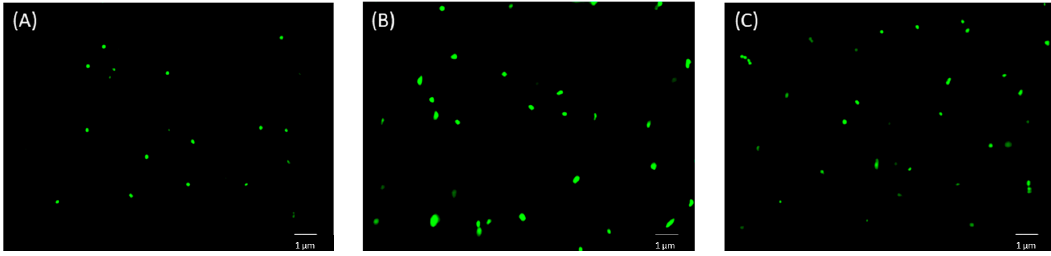
Figure 4. Effect of betulinic acid in the cell volume of ciprofloxacin treated S. aureus measured by fluorescence microscopy. S. aureus ATCC 6538 was incubated with ciprofloxacin (0.019 µg/mL) alone, or in combination with betulinic acid (200 µg/mL). After 3 h, the cells were labeled with acridine orange and analyzed using fluorescence microscopy. ( A ) Non-treated cells; ( B ) S. aureus treated with ciprofloxacin (0.019 µg/mL); ( C ) S. aureus treated with ciprofloxacin (0.019 µg/mL) and betulinic acid (200 µg/mL).